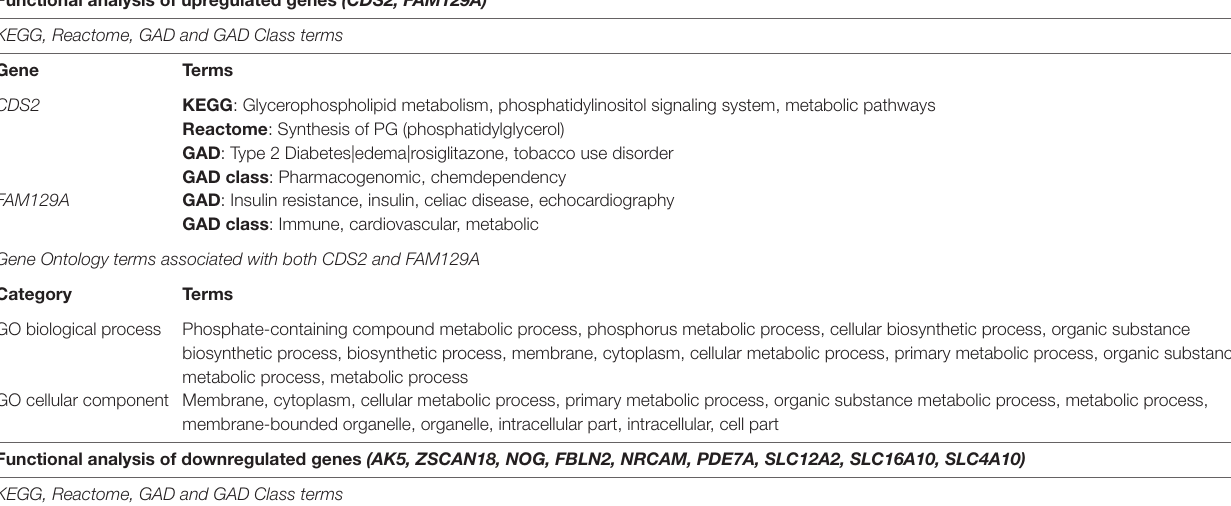
TABLE 4 | Functional analysis of eleven genes, which dysregulated expression in patients with LEAD was connected to miRNA modulatory function. Functional analysis of upregulated genes (CDS2, FAM129A) KEGG, Reactome, GAD and GAD Class